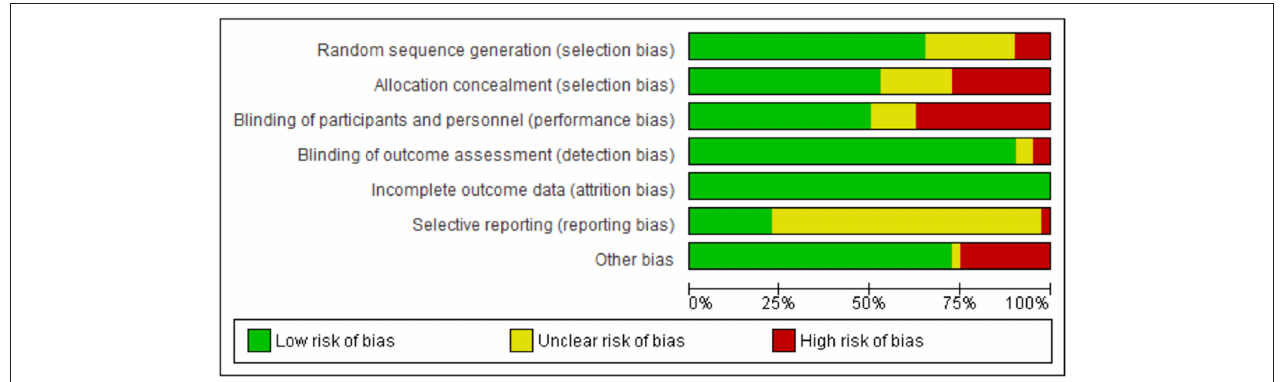
FIGURE 2 | Assessment of risk of bias presented as percentages across all included